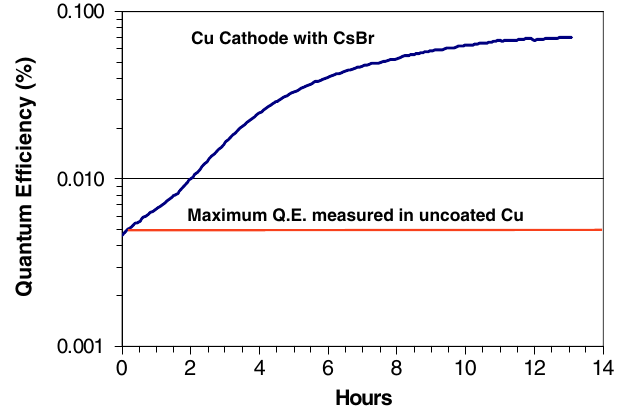
FIG. 2. (Color) Quantum efficiency (%) of CsBr = Cu sample irradiated at 4 : 8 W = cm 2 versus time before exposure to air. The initial activation (about 12 hours to reach a maximum Q.E.) of the CsBr = Cu photocathode at low power density is shown in the figure. The maximum Q.E. obtained for an un- coated Cu sample is shown for